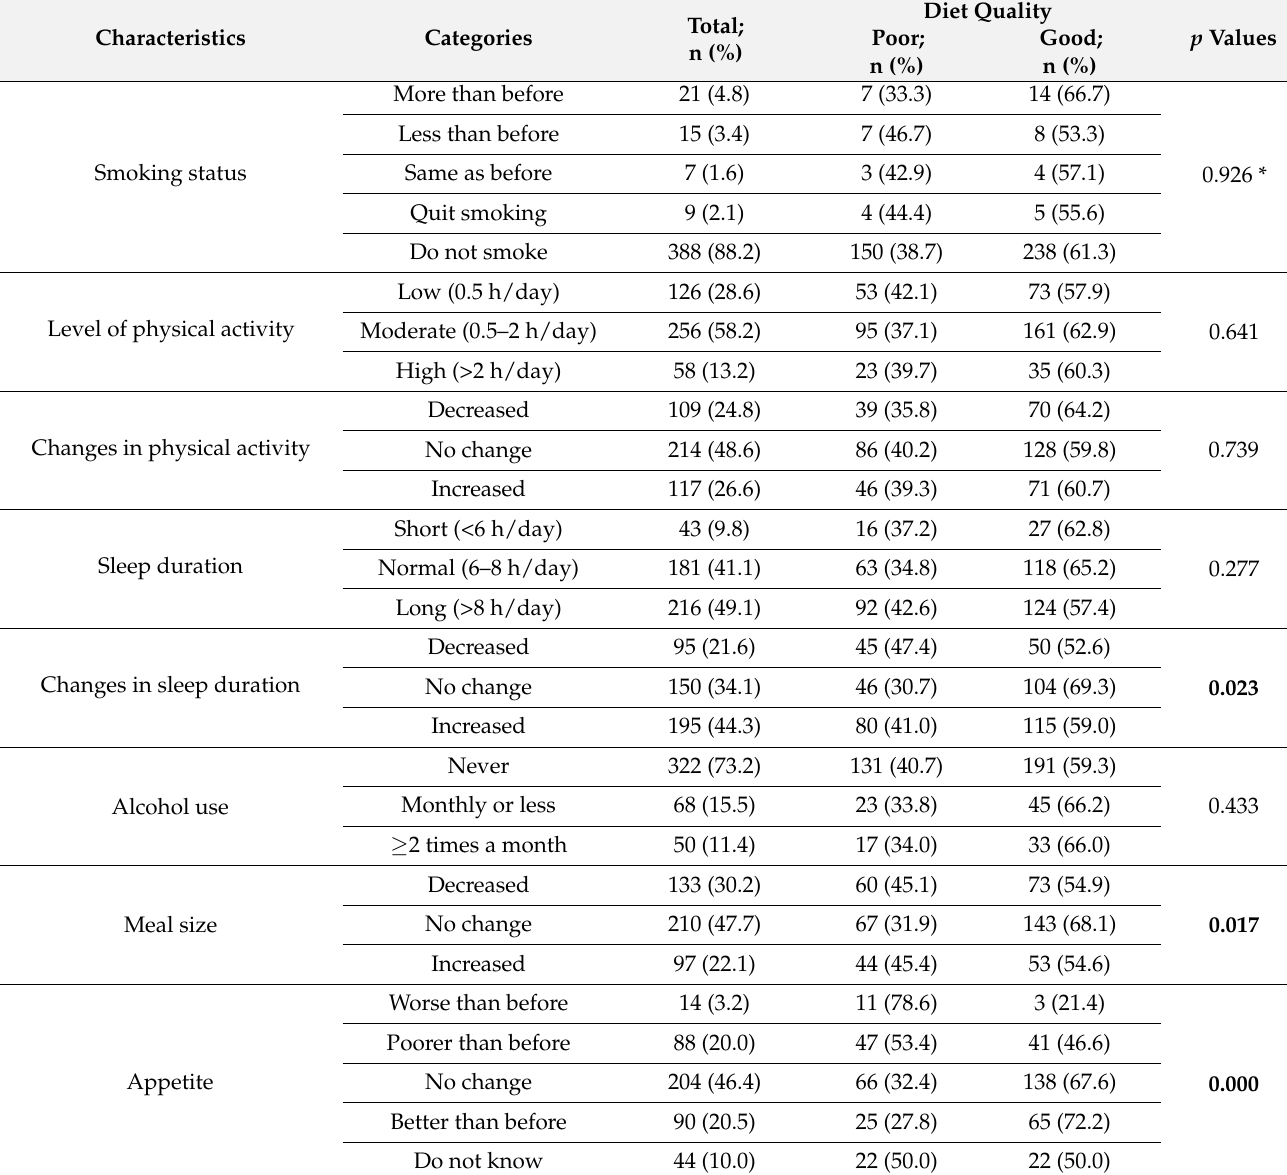
Table 2. Health and lifestyle characteristics and their changes during the COVID-19 lockdown of study participants (n =